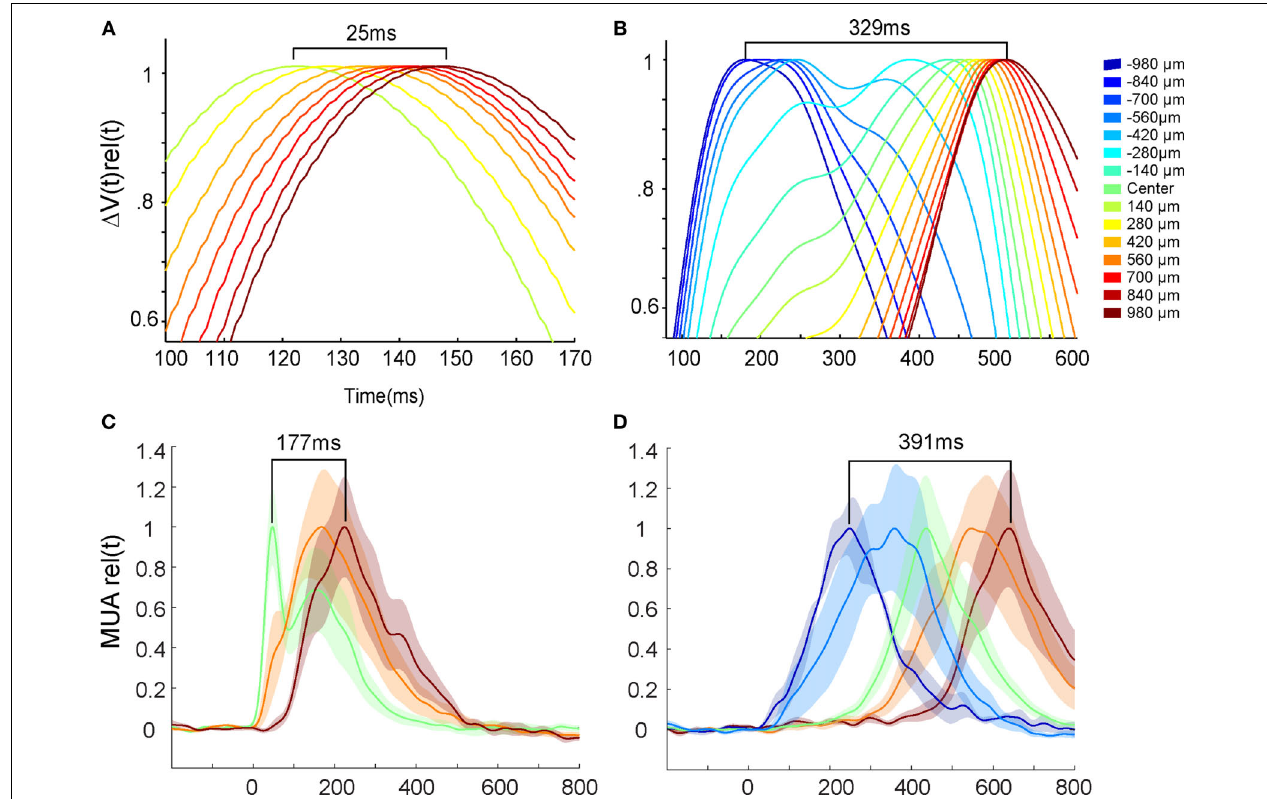
FIGURE 8 | Peak velocities of VSD signal and MUA. Top: The mean Δ V ( t ) rel( t ) signal from all animals taken from 15 locations at the 17/18 border and along the path of the moving object representation. Again upwards and downwards movement conditions have been pooled. (A) For a bar moving from CFOV the peaks move with a mean velocity of 0.039 mm ms − 1 in the time interval shown. (B) For a bar moving from the peripheral FOV the peak activity propagates over cortex with a mean velocity of 0.005 mm ms − 1 . Bottom: The mean MUA rel( t )